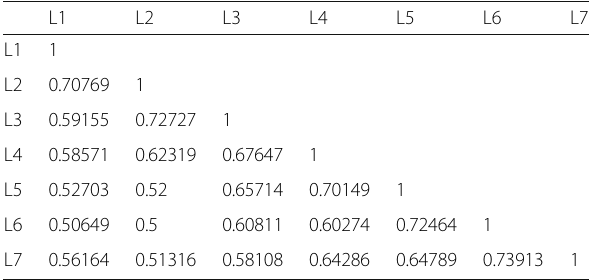
Table 18 Genetic similarity matrix between seven rice entries with ISSR markers based on Jaccard